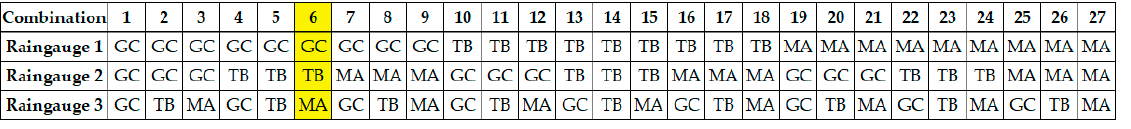
Figure 3. Combinations of rainfall input data with three rain